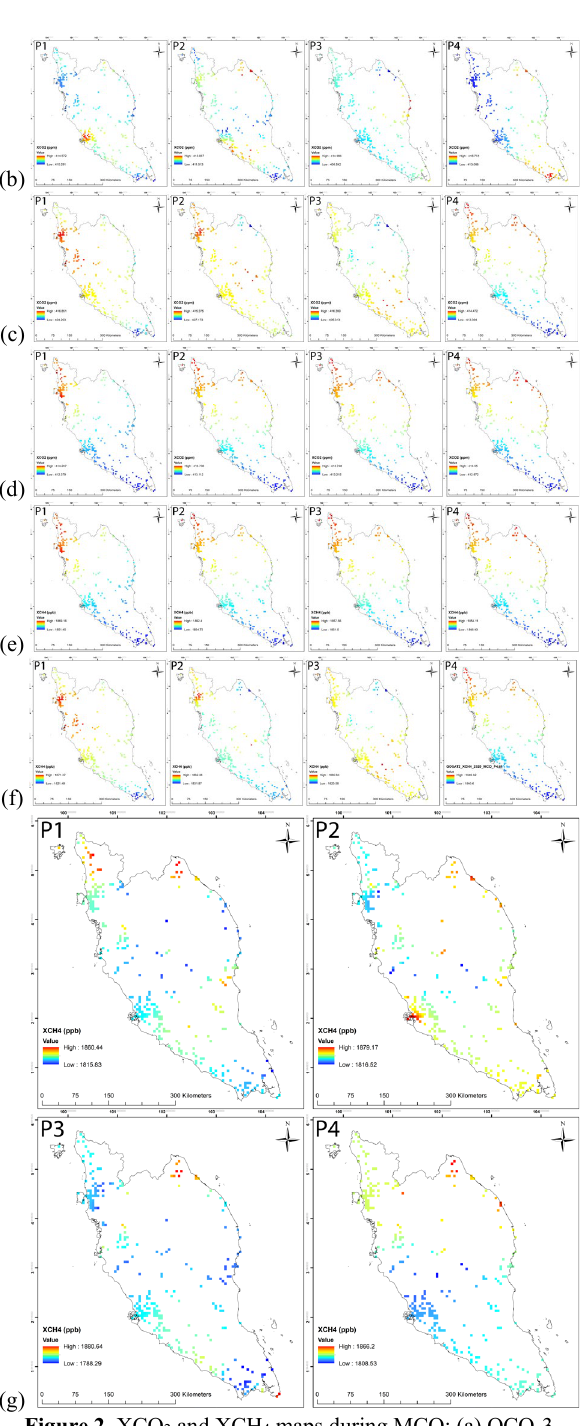
Figure 2. XCO 2 and XCH 4 maps during MCO: (a) OCO-3 XCO 2 , (b) OCO-2 XCO 2 , (c) GOSAT-2 XCO 2 , (d) GOSAT XCO 2 , (e) GOSAT XCH 4 , (f) GOSAT-2 XCH 4 , and (g) TROPOMI XCH 4 The XCO 2 of GOSAT, GOSAT-2, OCO-2, and OCO-3 during the MCO periods for the year 2019, 2020, and 2021 are in the range of 387.911-416.255 ppm, 402.564-417.309 ppm, and 409.473-419.712 ppm, respectively. Meanwhile, for the XCH 4 , the data are ranged between 1722.49-1874.82 ppb, 1788.29- 1880.61 ppb, and 1768.65-1896.81 ppb, respectively, for 2019, 2020, and 2021. The average XCO 2 and XCH 4 during the periods of MCO from 2019 to 2021 are illustrated in Figure